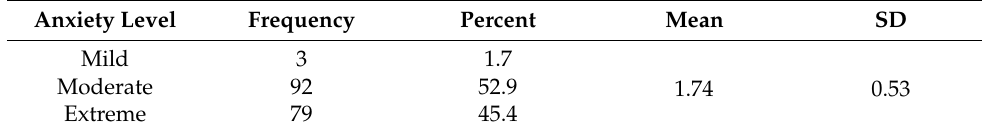
Table 2. Frequency distribution of teachers’ level of anxiety.